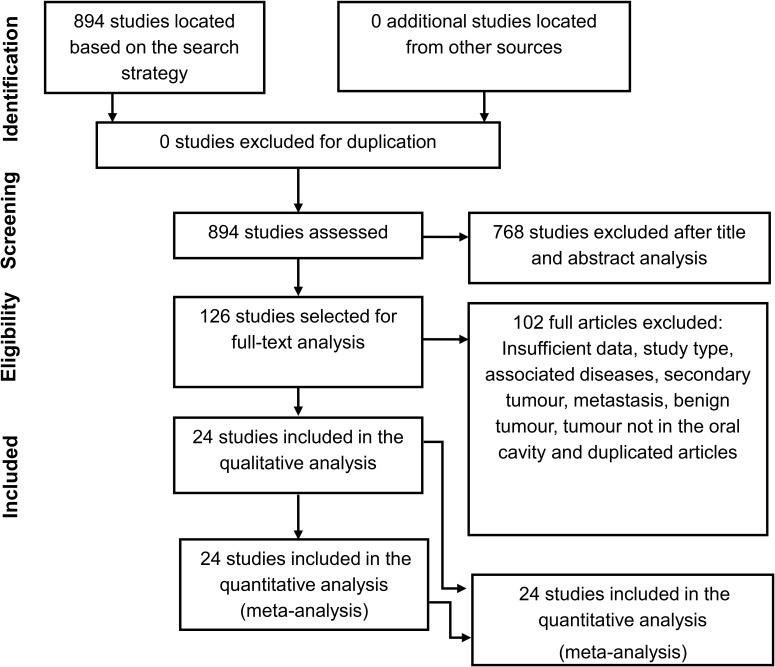
Study flow diagram.